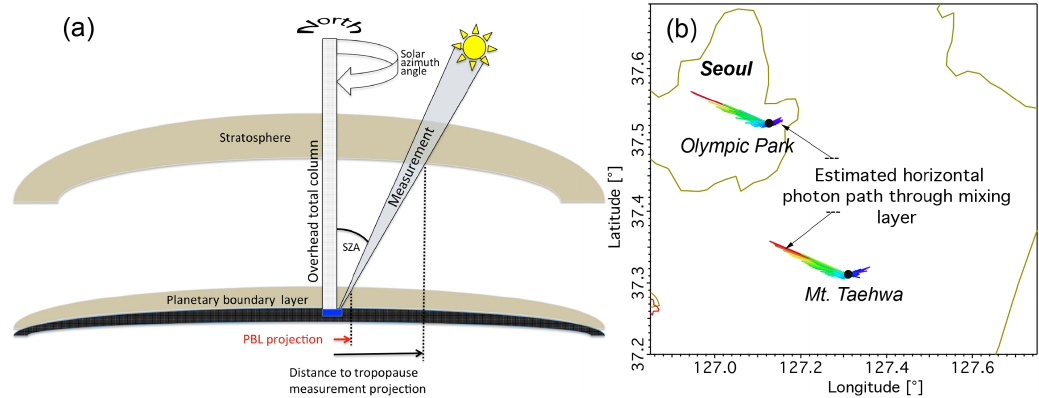
Figure 1. (a) Schematic of direct-sun-observation geometry; (b) estimated photon path through mixing layer derived from Vaisala Ceilometer CL51 backscatter profiles (910nm) over Olympic Park and Mt. Taehwa during KORUS-AQ. Color coding represents time of the day (blue – morning (horizontal distance: 1.5km); red – evening (horizontal distance: